Question: Which kind of chart has been used to present this data?
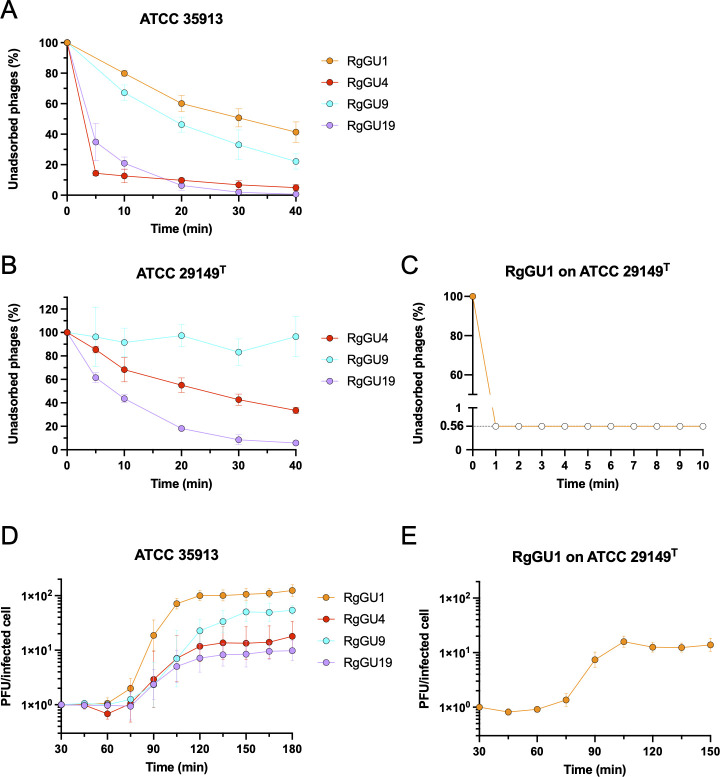
Answer: line